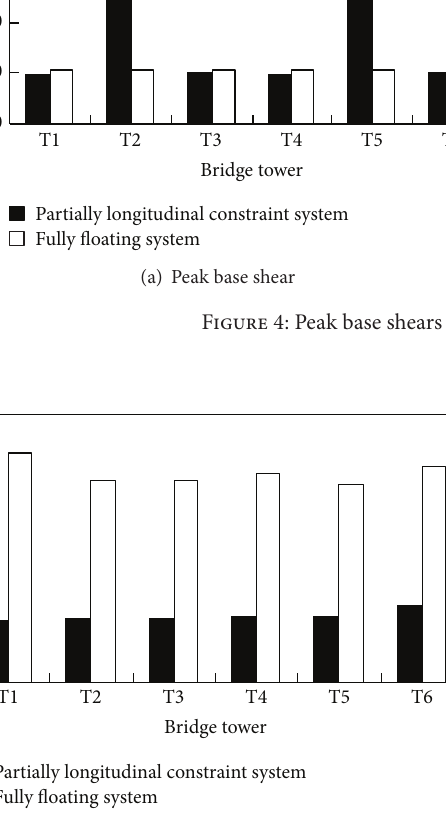
Figure 5: Peak displacements on the top of bridge